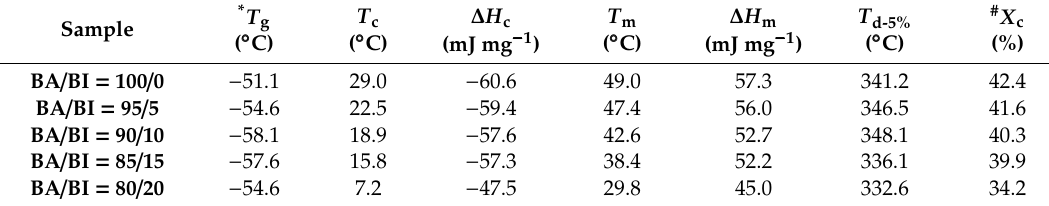
Figure 3. DSC trace of PBABI copolyesters: ( a ) cooling curves in the first cycle and ( b ) reheating curves in the second cycle. Table 2. Thermal properties of PBABI copolyesters. Table 2. Thermal properties of PBABI copolyesters.